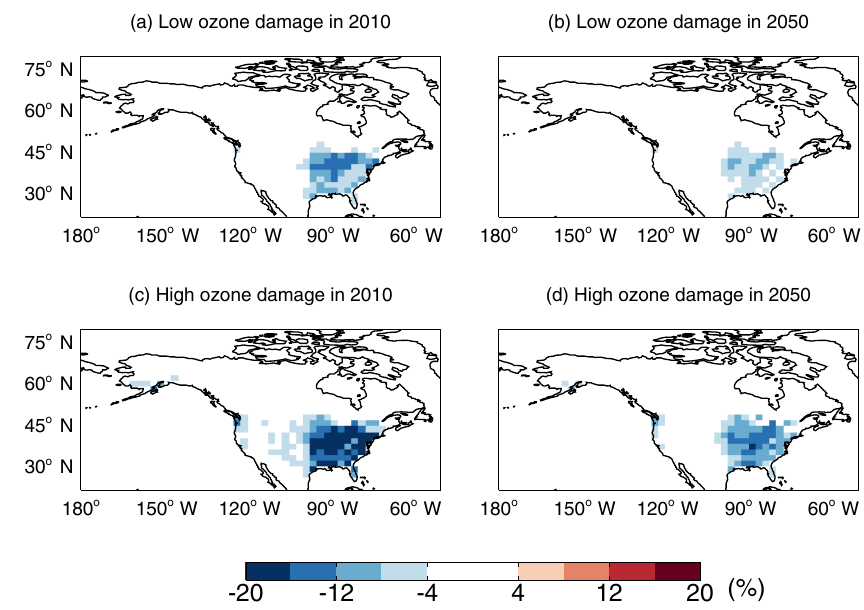
Figure 7. Simulated O 3 damages to summer GPP in North America. Results shown are from simulations with (a, b) low and (c, d) high O 3 sensitivities for (a, c) 2010 and (b, d) 2050. Simulated [O 3 ] includes contributions from both wildfire and non-fire emissions. Results for 2010 are derived as (F10O3/F10CTRL-1) · 100%. Results for 2050 are derived as (F50O3/F50CTRL-1) · 100%.